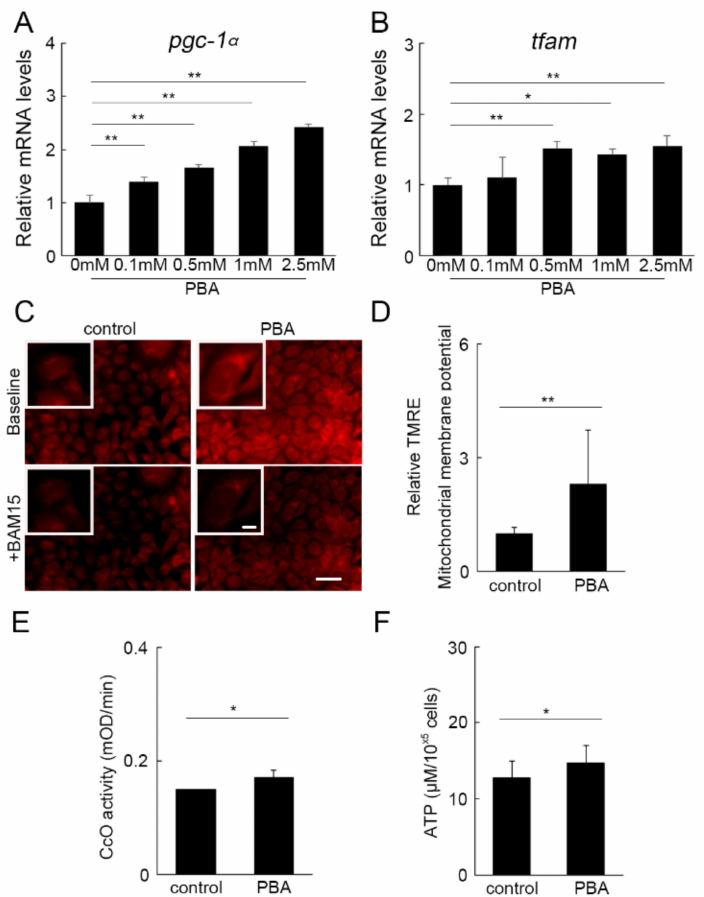
Figure 5. OXPHOS activation by PBA ( A – F ) HEK 293 cells incubated with or without PBA for 24 h. RT-PCR showed that pgc-1 α ( A ) and tfam ( B ) increased by PBA in a dose-dependent manner. Mitochondrial membrane potential measured using TMRE, a fluorescent dye ( C ) showed that PBA increased the membrane potential ( C , D ). BAM15, a mitochondria protonophore uncoupler, was added to cancel the membrane potential, and the subtracted values of the fluorescence intensity representing the potential were shown in the graph ( D ). CoxIV (CcO) activity ( E ) and ATP levels ( F ) also increased by PBA. Data are shown as mean ± standard deviation. n for vehicle and PBA groups, ( A – E ) 3–4; ( F ) 13–14. OXPHOS, oxidative phosphorylation, CcO; cytochrome c oxidase. * p < 0.05, ** p < 0.01. Scale bars; 50 µ m for the images in the large panels, and 10 µ m for the magnified images in the